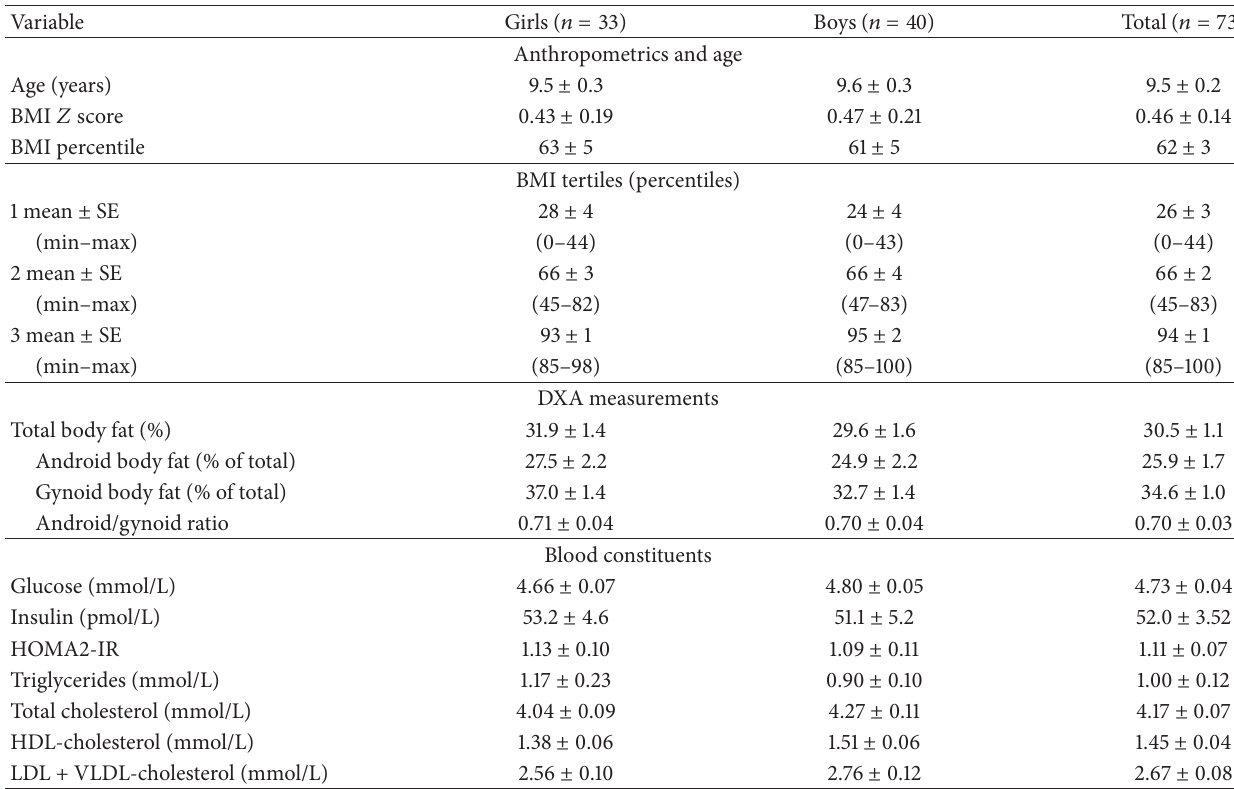
Table 1: Characteristics, anthropometrics, and biochemistries of participants, stratified by sex and combined (mean ± SE). Variable